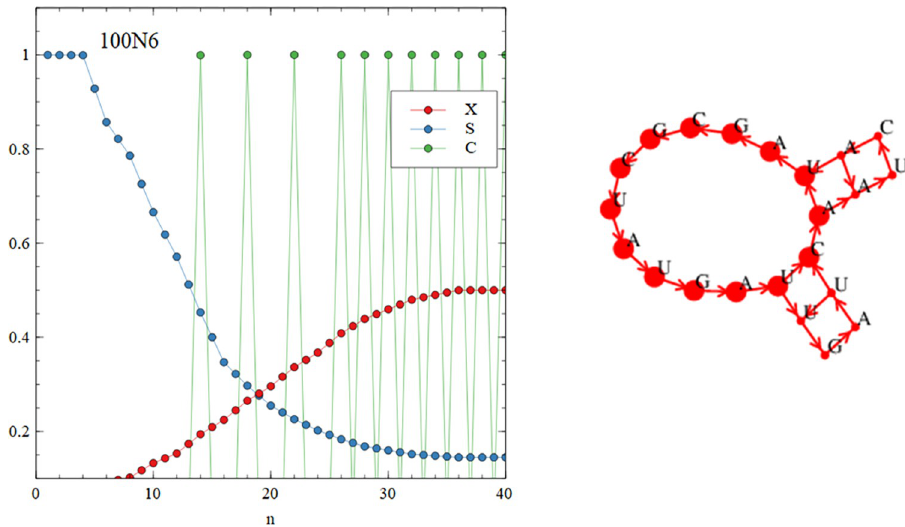
Fig 11. The graph functions and word graph for run 100N6 show the presence of cycles of period 14,18 and 22.